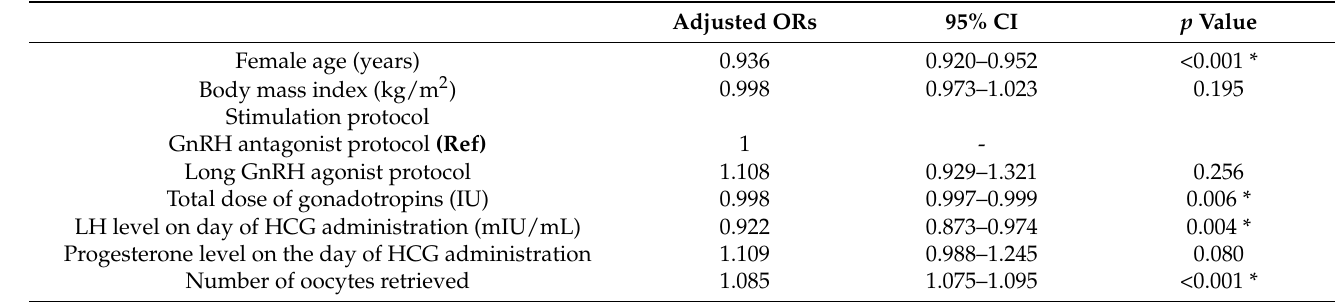
Table 2. Multivariate logistic regression analysis for the cumulative live birth rate.